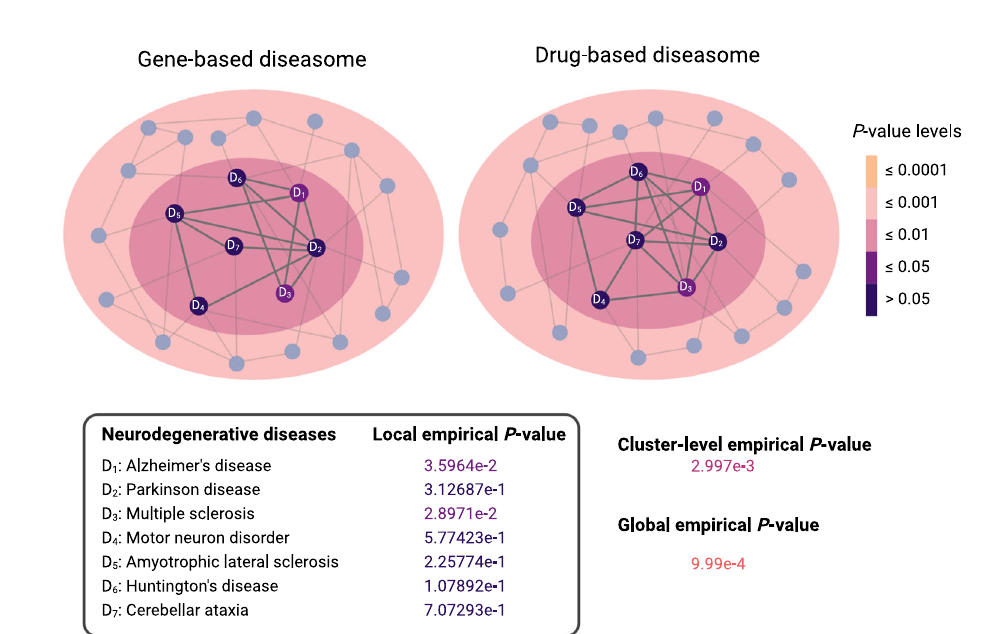
Fig. 1 | BEV vs. close-up network medicine. a BEV network medicine mainly uti- lizes large-scale disease association data where diseases are annotated with phenotype-based disease de fi nitions ( b , bottom). BEV network medicine inherits thebiasintroducedbythesede fi nitions,whichleadstoablurredviewonindividual